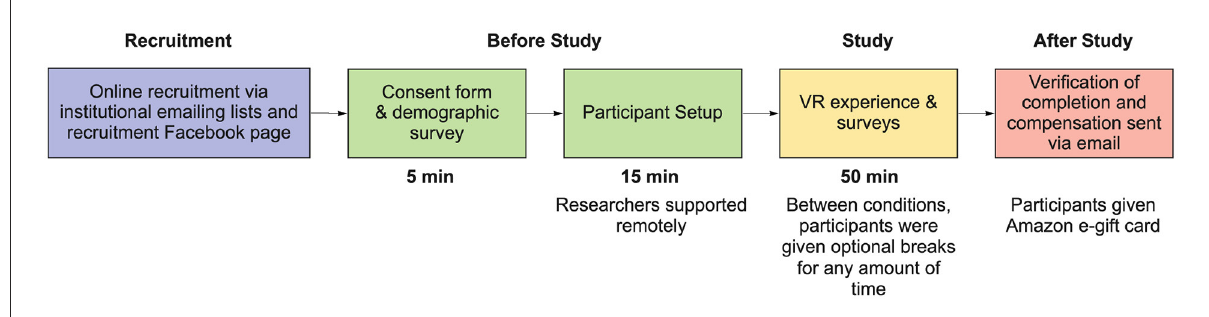
FIGURE4 Visualization of the study procedure of the “IMPReSS” selection technique